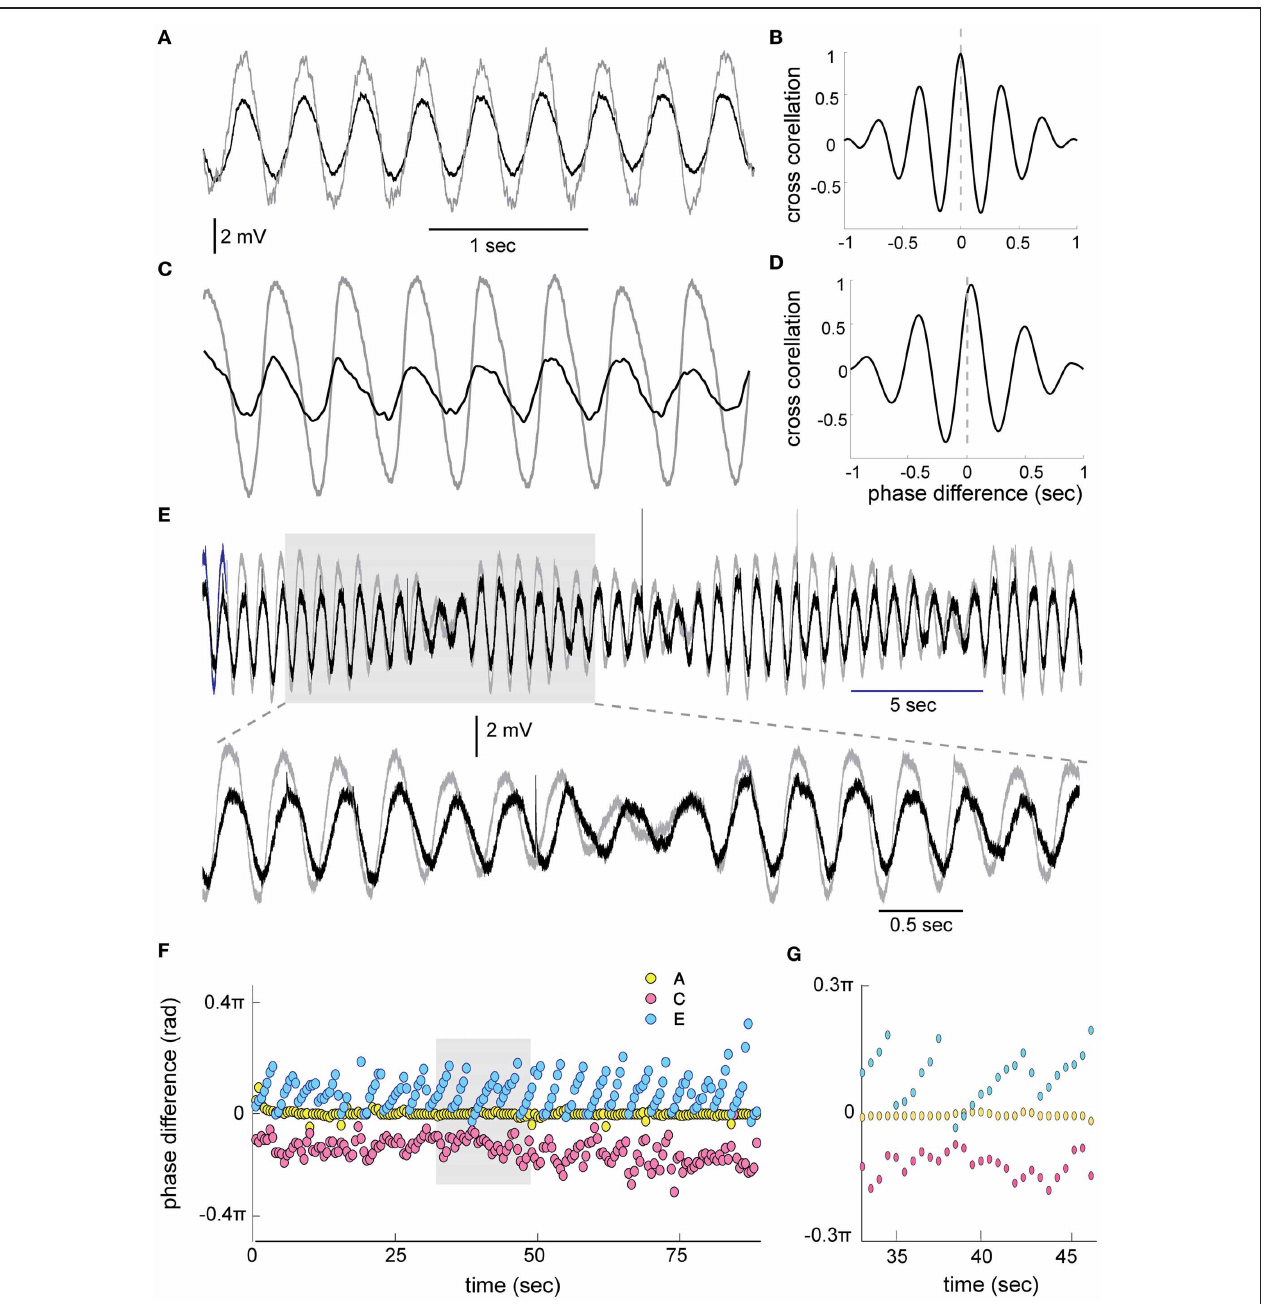
FIGURE 3 | Phase relationship between STO in 2 simultaneously recorded olivary cells. (A) An example of zero phase difference between two cells. (B) The cross correlation calculated between the two waves on 1s of recording showing the zero phase. (C,D) The same as in (A,B) for two cells showing approximately 0 . 07 × 2 π (33ms) phase difference (STD ± 0.02). (E) An example of STO in two cells displaying slow amplitude modulation. The